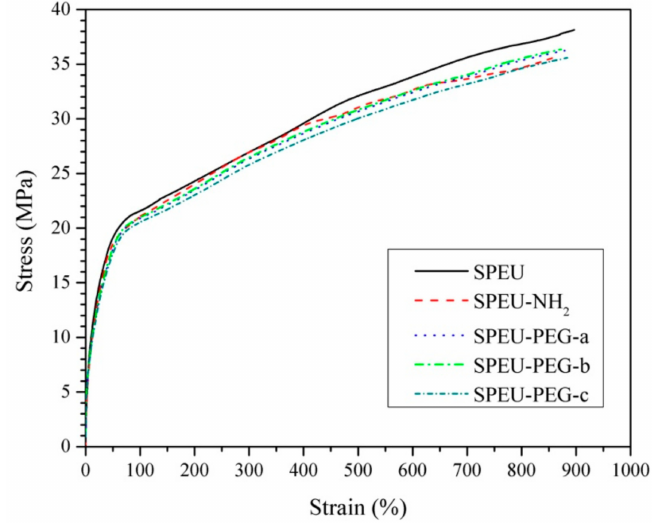
Figure 5. Stress-strain behaviors of blank and modified SPEU films. Table 2. Mechanical properties of CPU